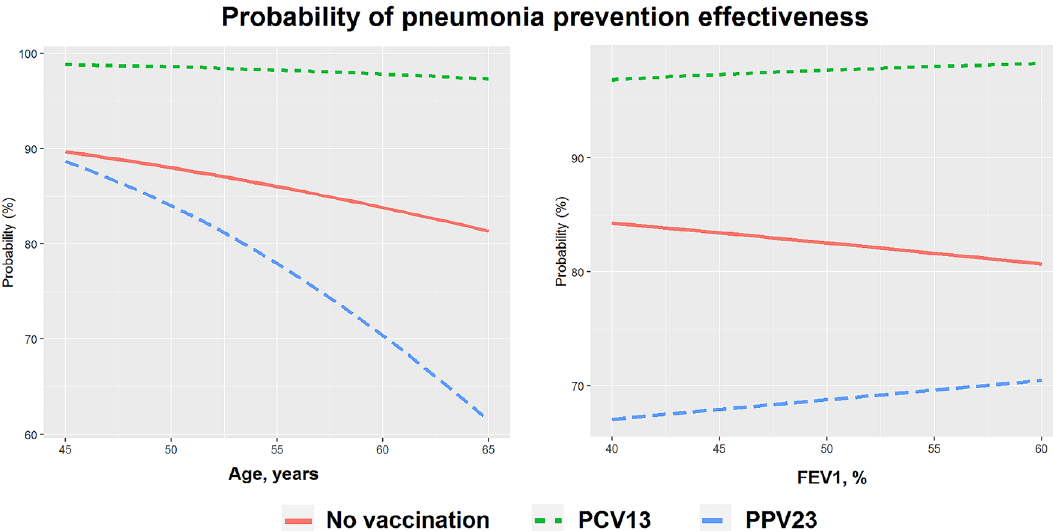
Figure 7. Multivariable model of probability of pneumonia prevention